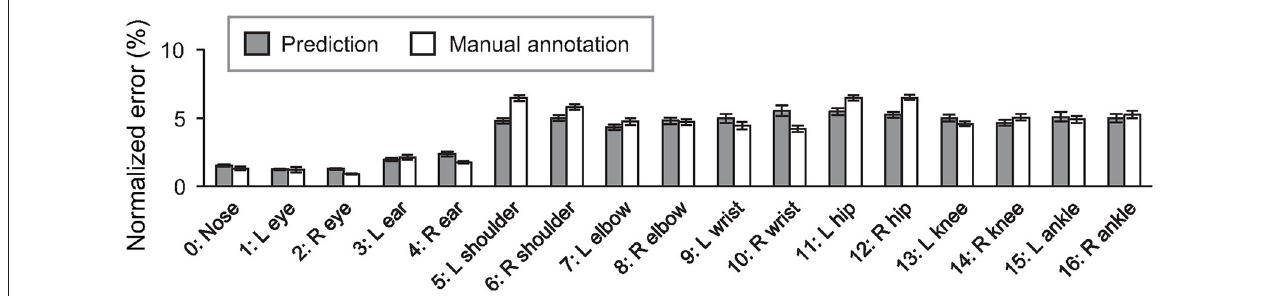
FIGURE 3 | Averaged error of predicted (gray) and manual labeled (white) positions of each keypoint comparing with the ground truth positions. Error bars represent standard error of the mean (s.e.m).